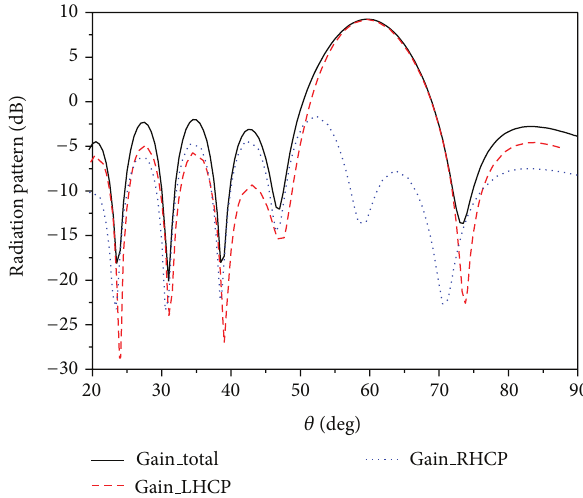
Figure 10: Comparisons of axial ratios of the antennas with N- shaped slots and the antenna with H-shaped slot given in [9].